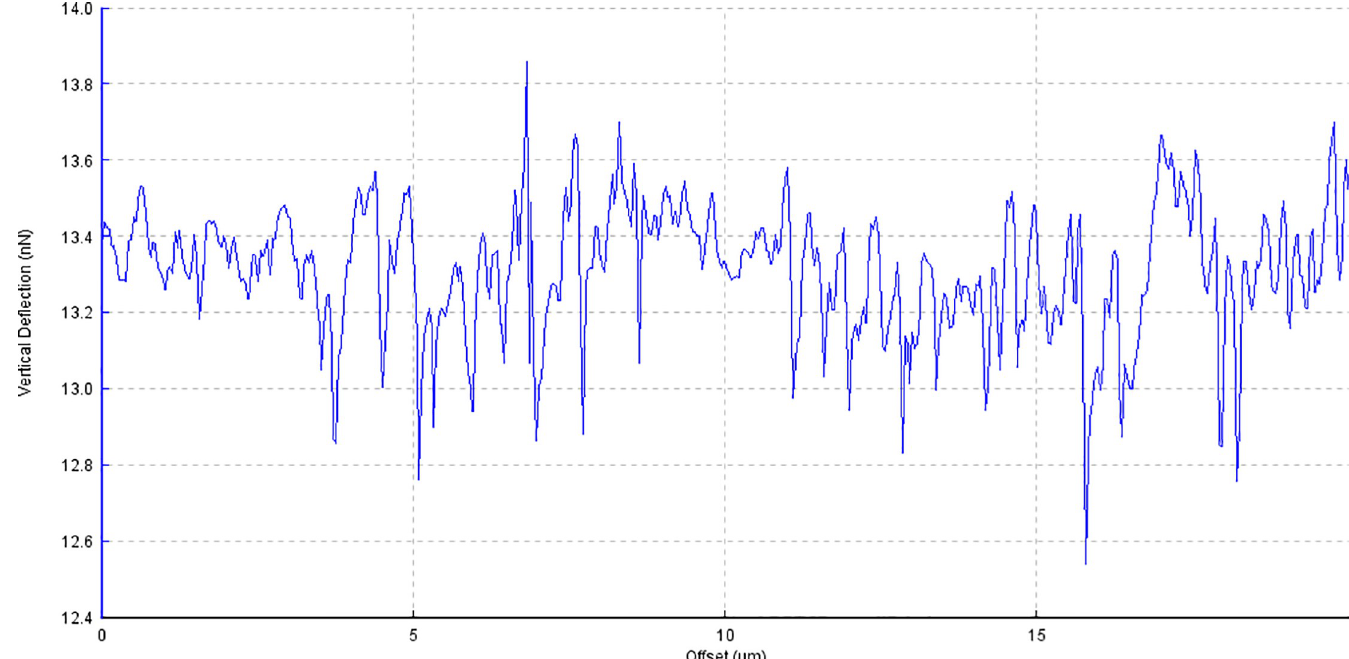
Fig 7. Example image of corneal surface treated with FS1 with AFM line